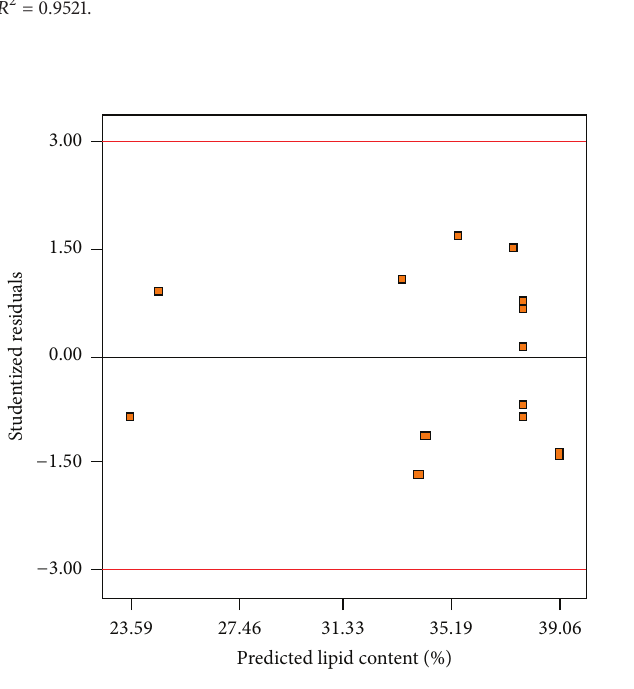
Figure 8: Plot of studentized residuals versus the predicted lipid